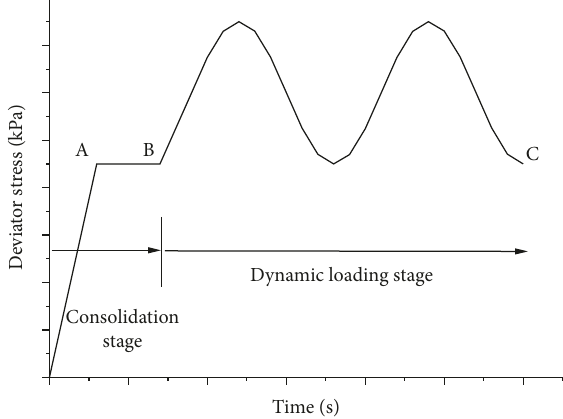
Figure 2: Loading process of the cyclic triaxial test.